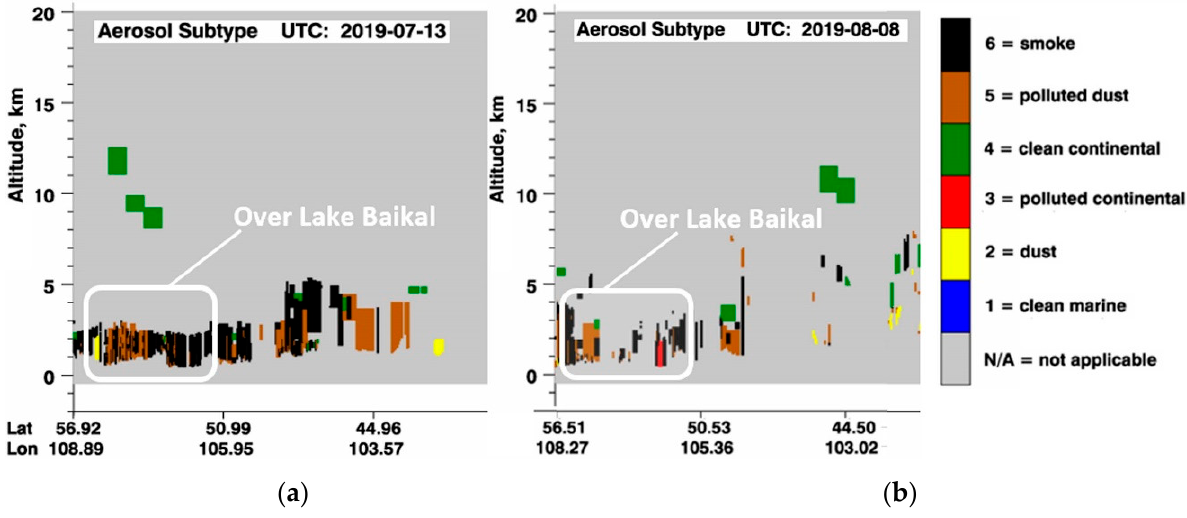
Figure 3. The plot of CALIPSO aerosol vertical profile. The X axis – latitude and longitude, the Y axis - altitude, the colors scale – type of aerosol. ( a ) aerosol subtype, UTC: 2019-07-13; ( b ) aerosol subtype, UTC: 2019-08-08.